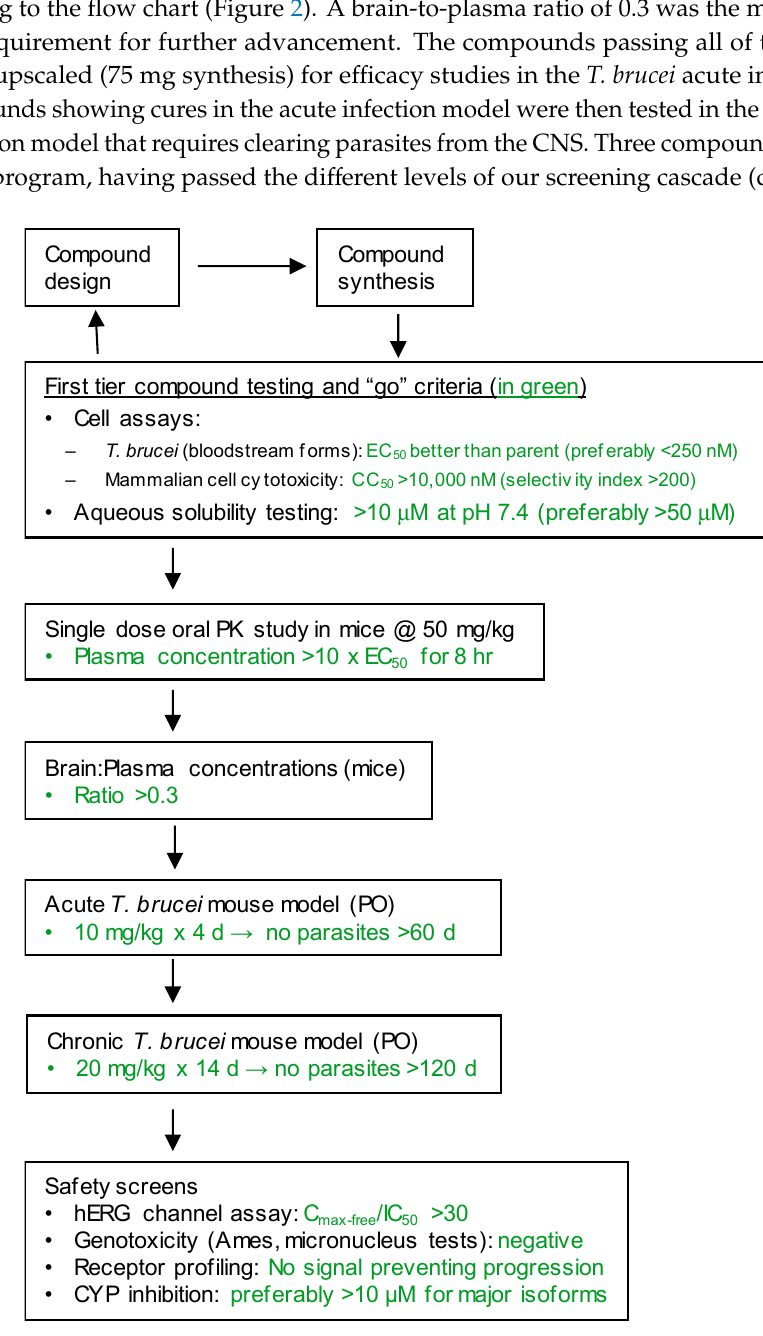
Figure 2. Screening cascade.